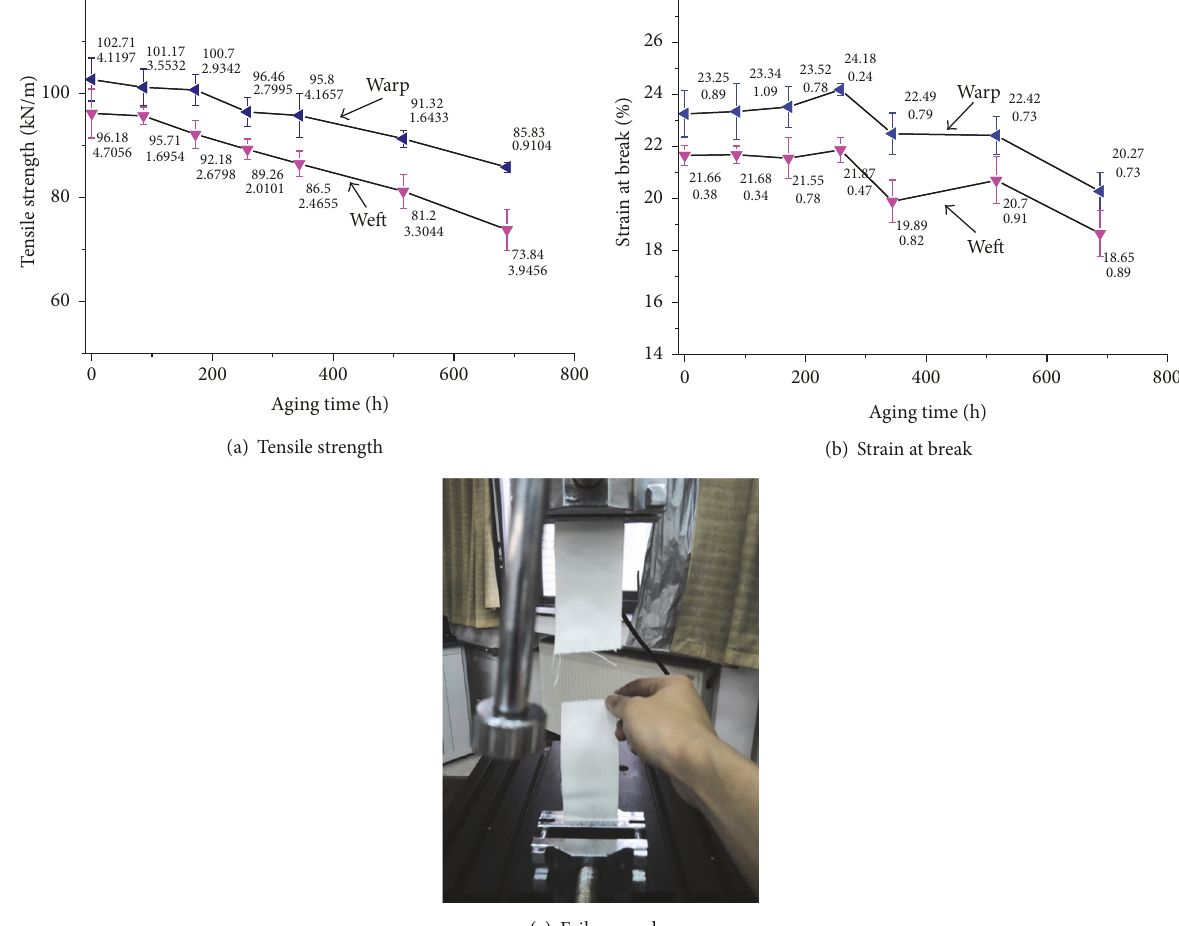
Figure 2: Tensile strength and strain at break after different aging